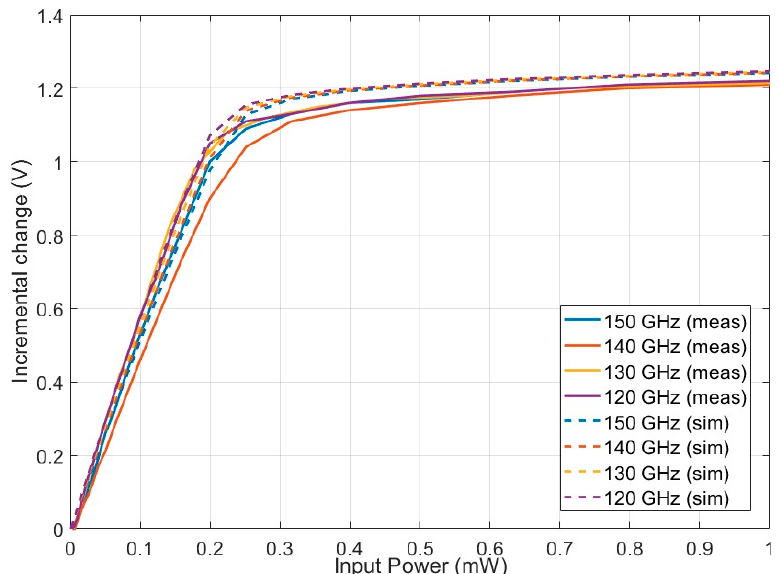
Figure 9. A photo of the fabricated power detector. The chip size including pads is 700 µ m by 400 µ m.